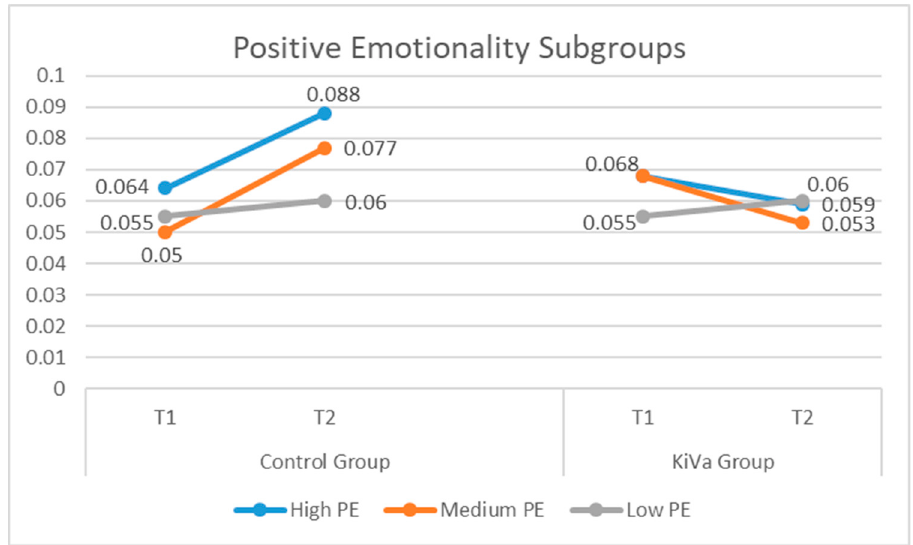
Figure 3. Victimization across time distinguishing between control and KiVa groups, and high, medium, and low levels of positive emotionality.